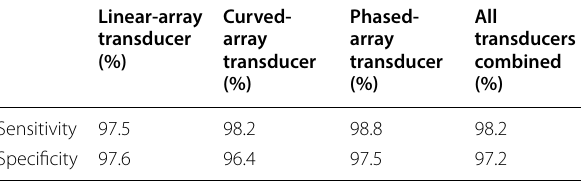
Table 2 Diagnostic performance of the three ultrasound transducers for pneumothorax